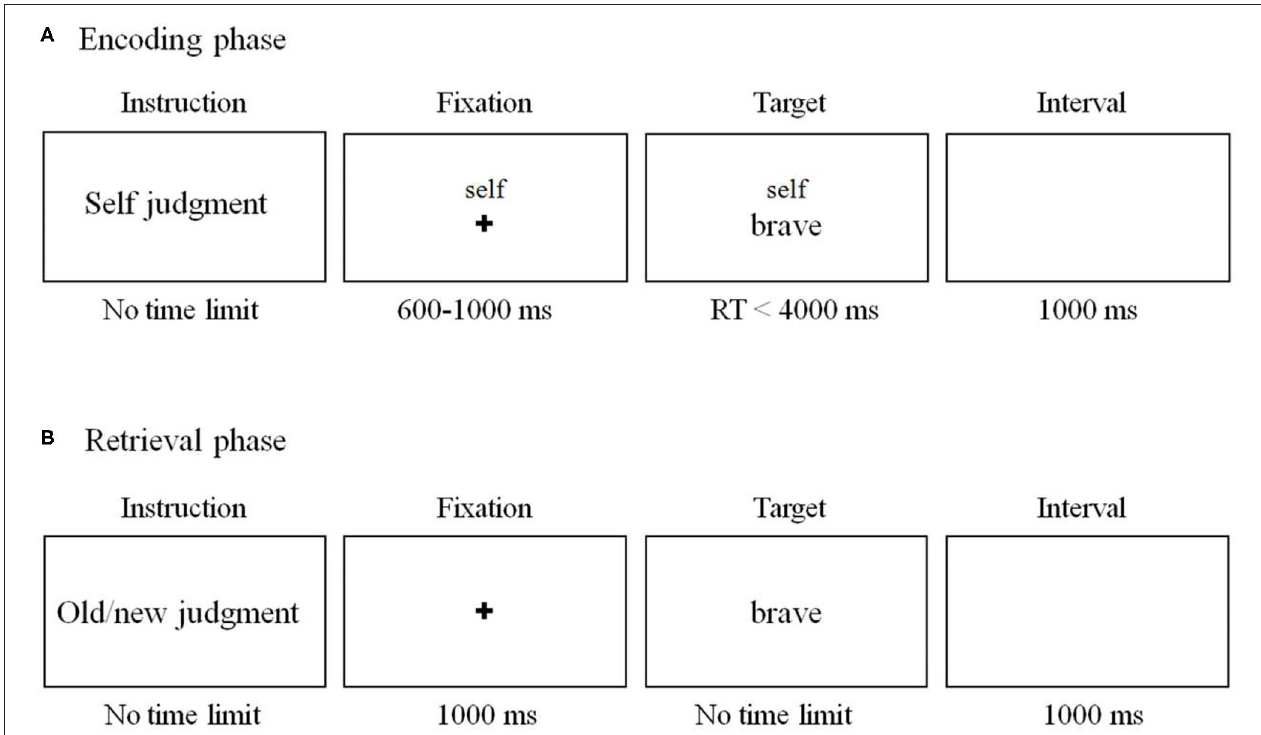
FIGURE 1 | Schema of the self-referential effect (SRE) task in the current study. (A) Encoding phase. The stimuli and procedure of mother- and other-referential conditions were the same as those of the self-referential condition except that the word “self” on the screen was replaced by “mother” and “Jintao Hu.” (B) Sample stimuli and schematic of a sample trial in retrieval